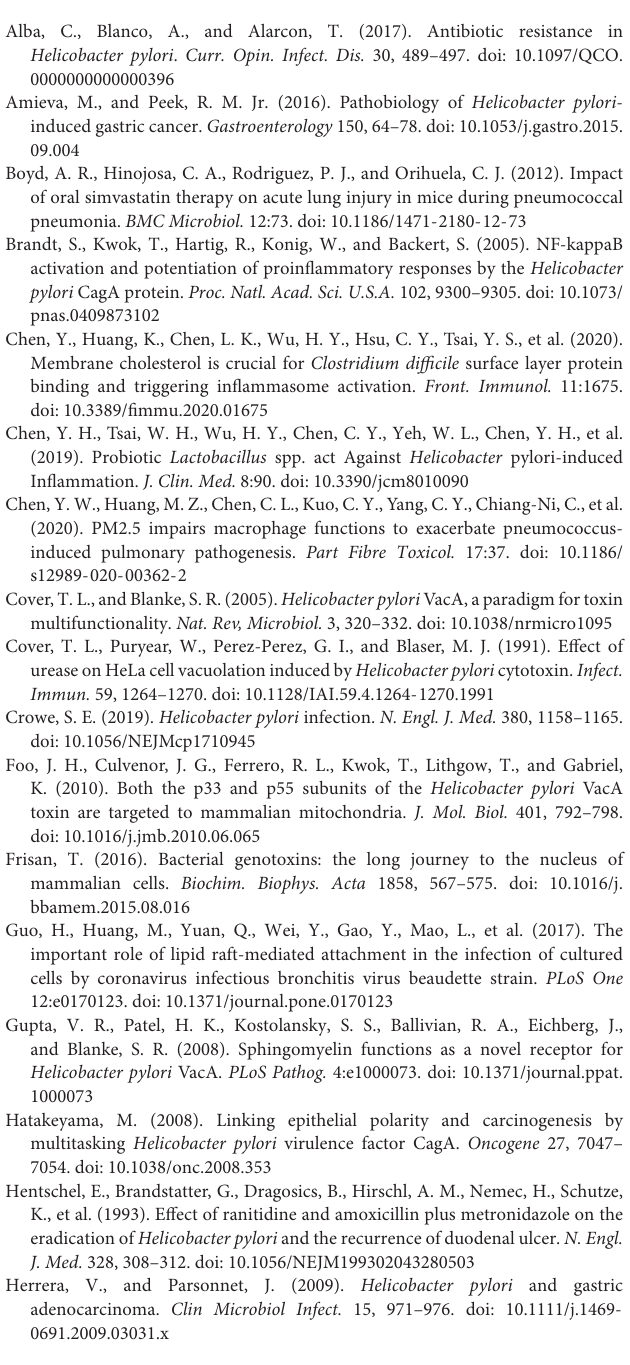
2 h. The cells were probed with anti-CdtC (yellow), the plasma membrane was stained with WGA-conjugated Alexa Flour 594 (red), and the nuclei were stained with Hoechst 33342 (blue). The image was observed under a confocal microscope with × 63 oil immersion objective and processed by software ZEN. Arrows indicate the CagA translocated into the cytoplasm. Scale bar, 5 µ m. (B) The distribution of fluorescence intensity for CdtC (yellow line), CagA (green line), and plasma membrane (red) signals across the white lines was calculated and presented as line intensity histograms in the right panels. The area within the cell